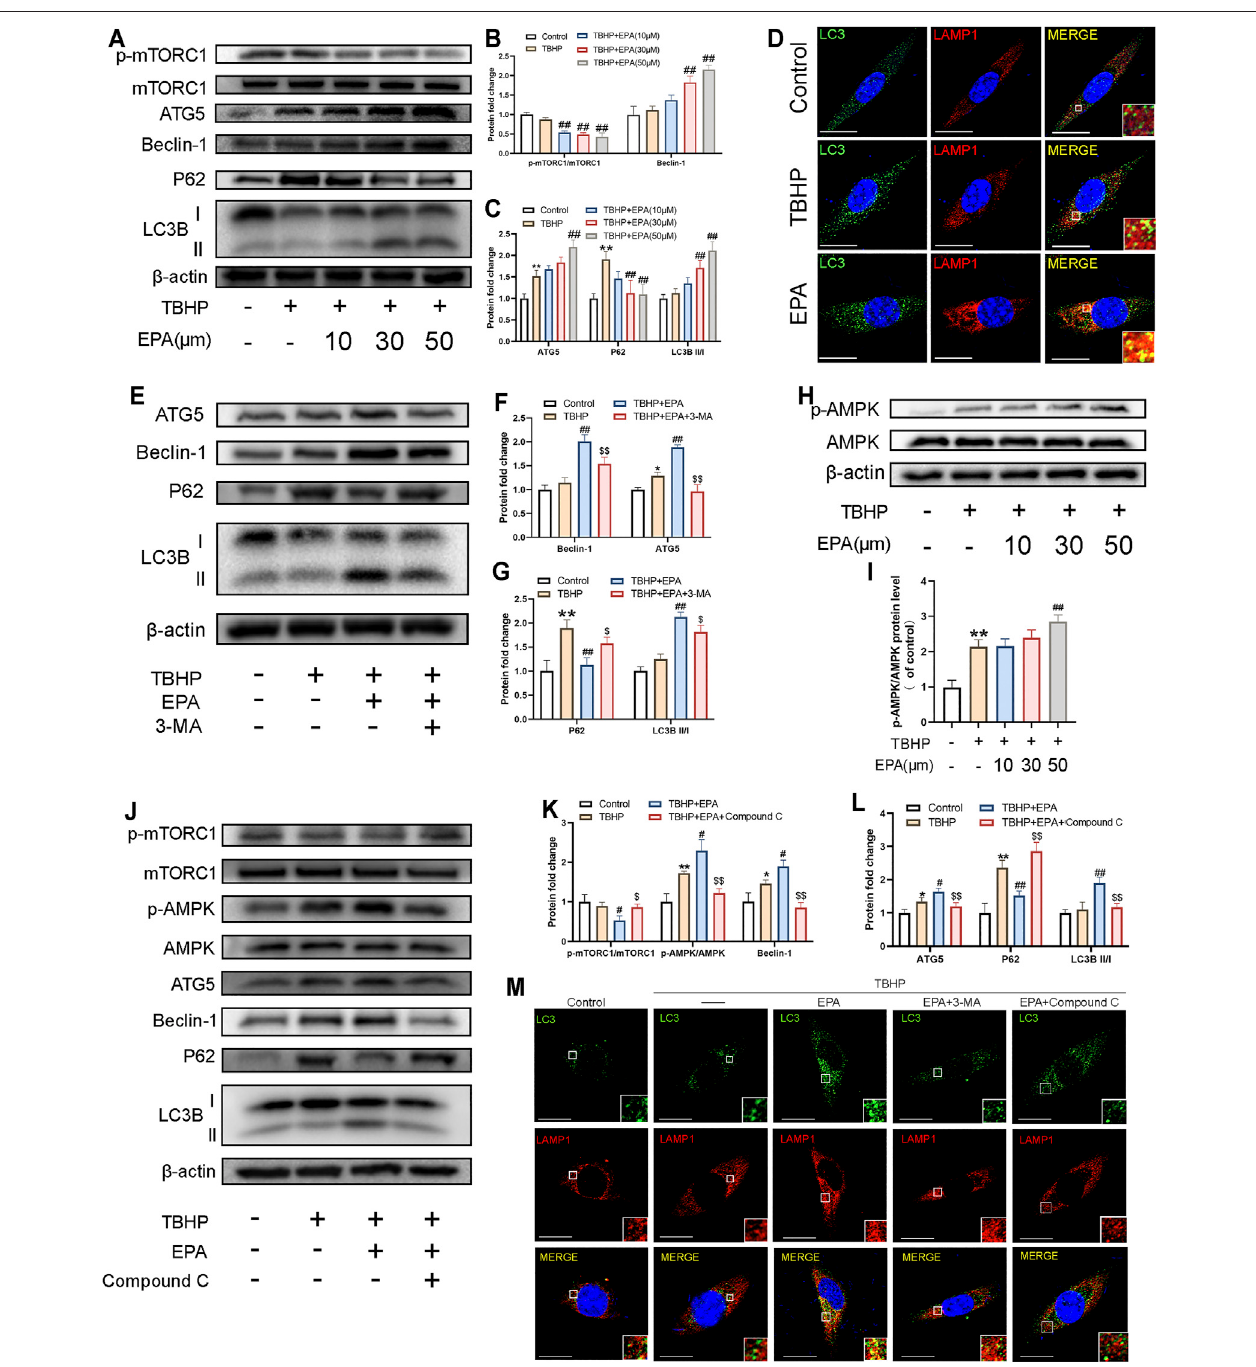
FIGURE 4 | EPA can promote autophagy in NPCs, and the EPA-activated autophagy can be blocked by 3-MA and Compound C. (A – C) The protein expression of p-mTORC1/mTORC1,Beclin-1,ATG5,P62,LC3BII/IinNPCstreatedwithdifferentconcentrationsofEPAwasvisualizedbywesternblotting. (D) Therepresentativeimages of double immuno fl uorescence staining in NPCs treated as above (green signals represent LC3B, red signals represent LAMP1, scale bar: 10 μ m). (E – G) The protein expressionofBeclin-1, ATG5, P62,LC3II/I inNPCstreated withEPA and 3-MAwere visualized by western blotting. (H,I) The proteinexpressionofp-AMPK/AMPKin NPCstreated withdifferent concentrationsofEPAwasvisualizedbywestern blotting. (J – L) p-mTORC1/mTORC1, p-AMPK/AMPK,Beclin-1, ATG5,P62,LC3BII/IinNPCs treatedwithEPAandCompoundC. (M) Thedoubleimmuno fl uorescencestainingofLC3BandLAMP1inTBHP-exposedNPCstreatedwithEPA,3-MAandCompoundC (greensignalsrepresentLC3B,red signalsrepresentLAMP1,scalebar:10 μ m). The valuespresented arethemeans ± SD( n (cid:2) 3). * p < 0.05, ** p < 0.01, compared withthe control group; # p < 0.05, ## p < 0.01, compared with the TBHP treatment group; $ p < 0.05, $$ p < 0.01, compared with the TBHP and EPA treatment group.